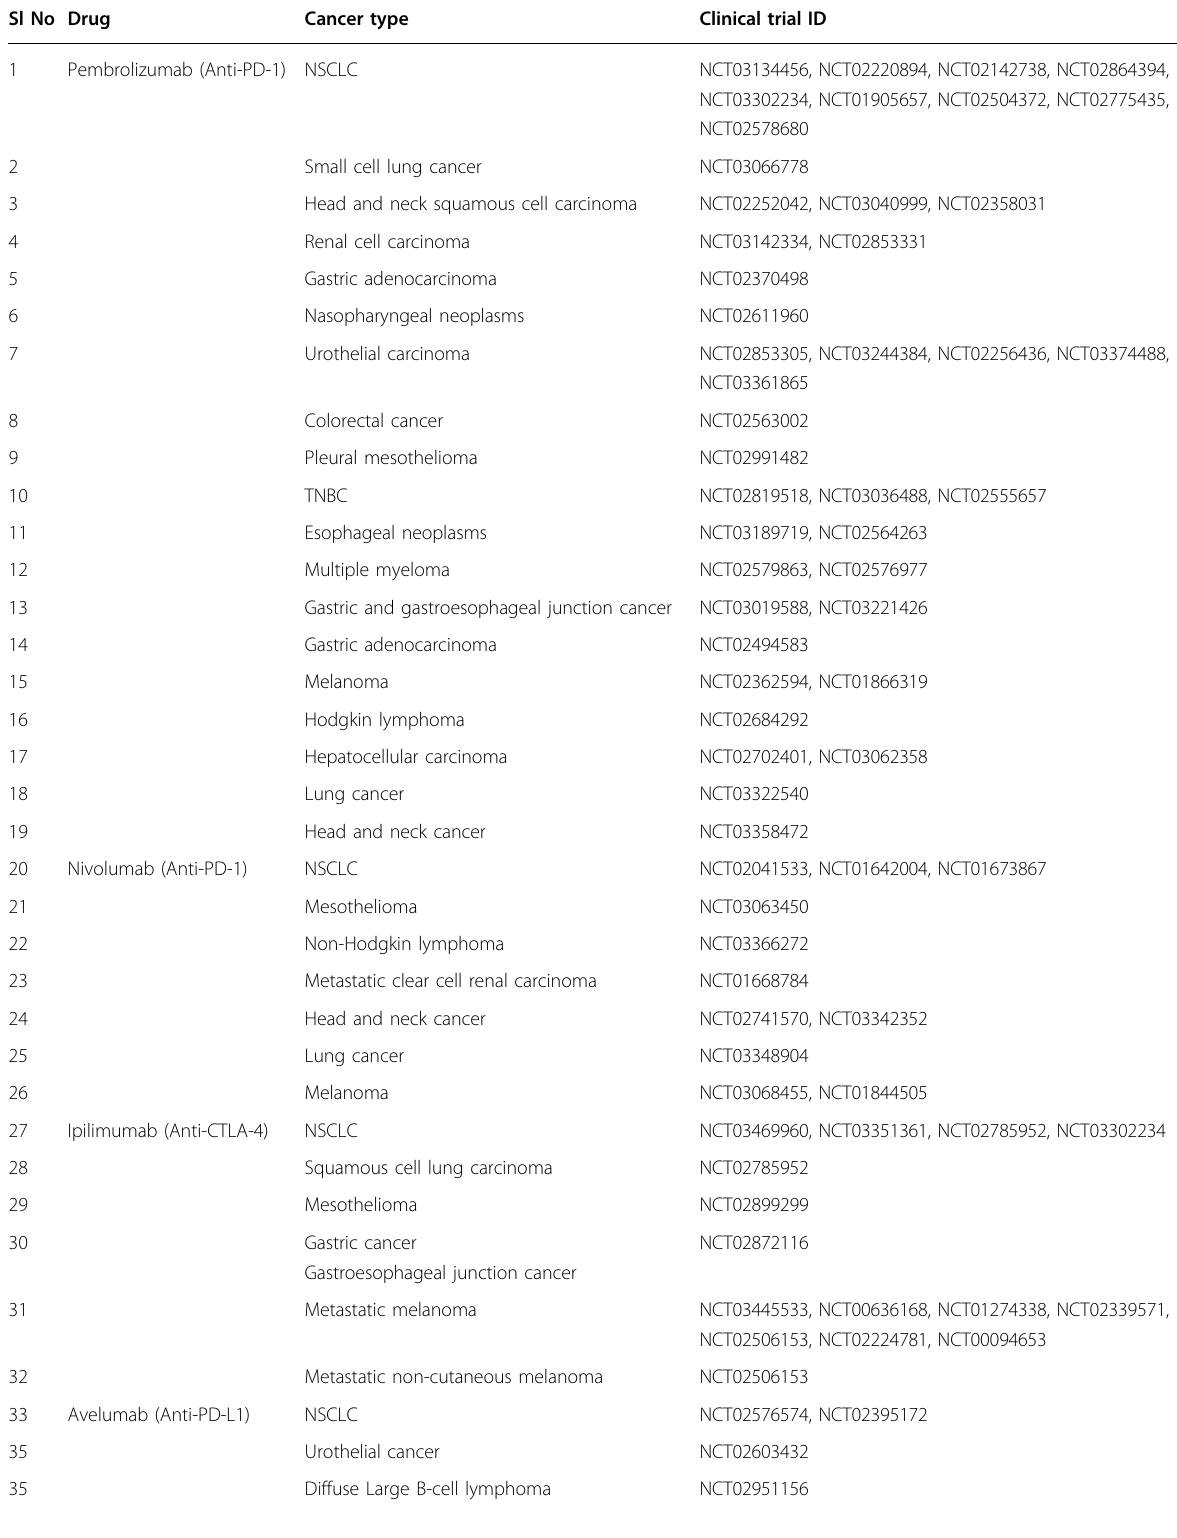
Table 1 Immune checkpoint inhibitors in phase III and IV clinical